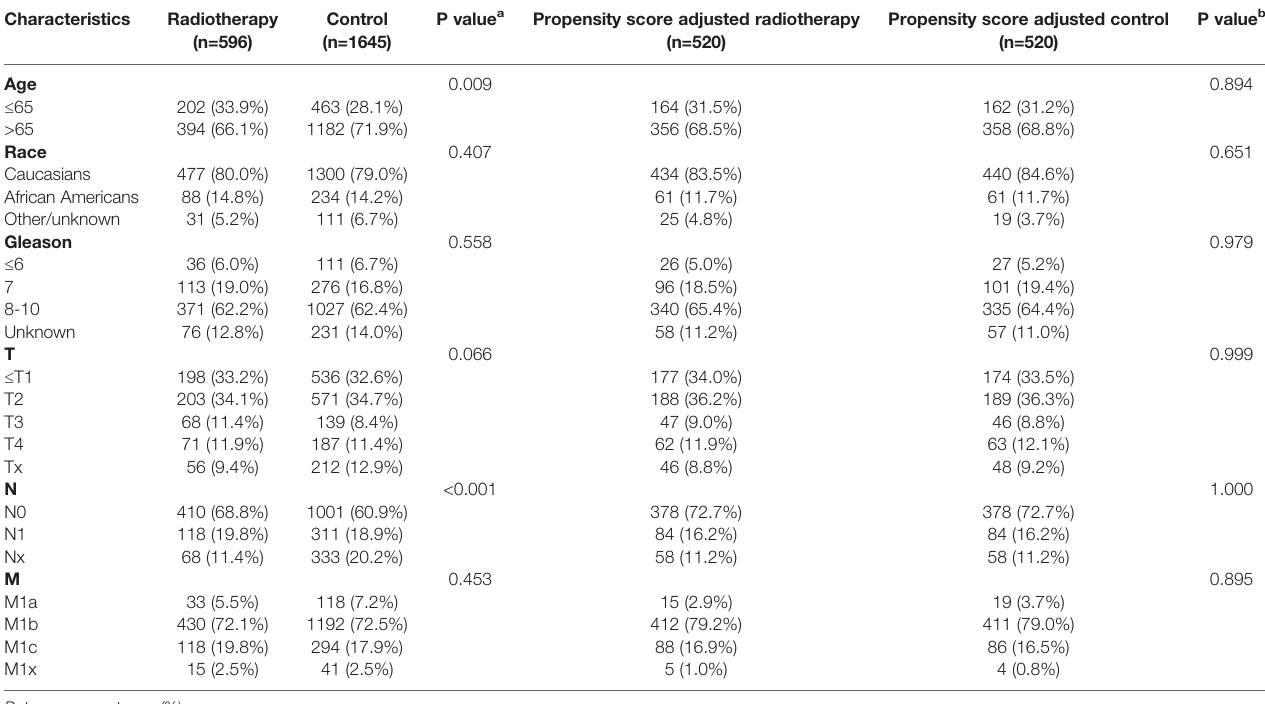
TABLE 5 | Clinicopathological characteristics of the PSA 10.1-20 ng/ml subgroup strati fi ed according to treatment modality with and without propensity score matching. Characteristics Radiotherapy